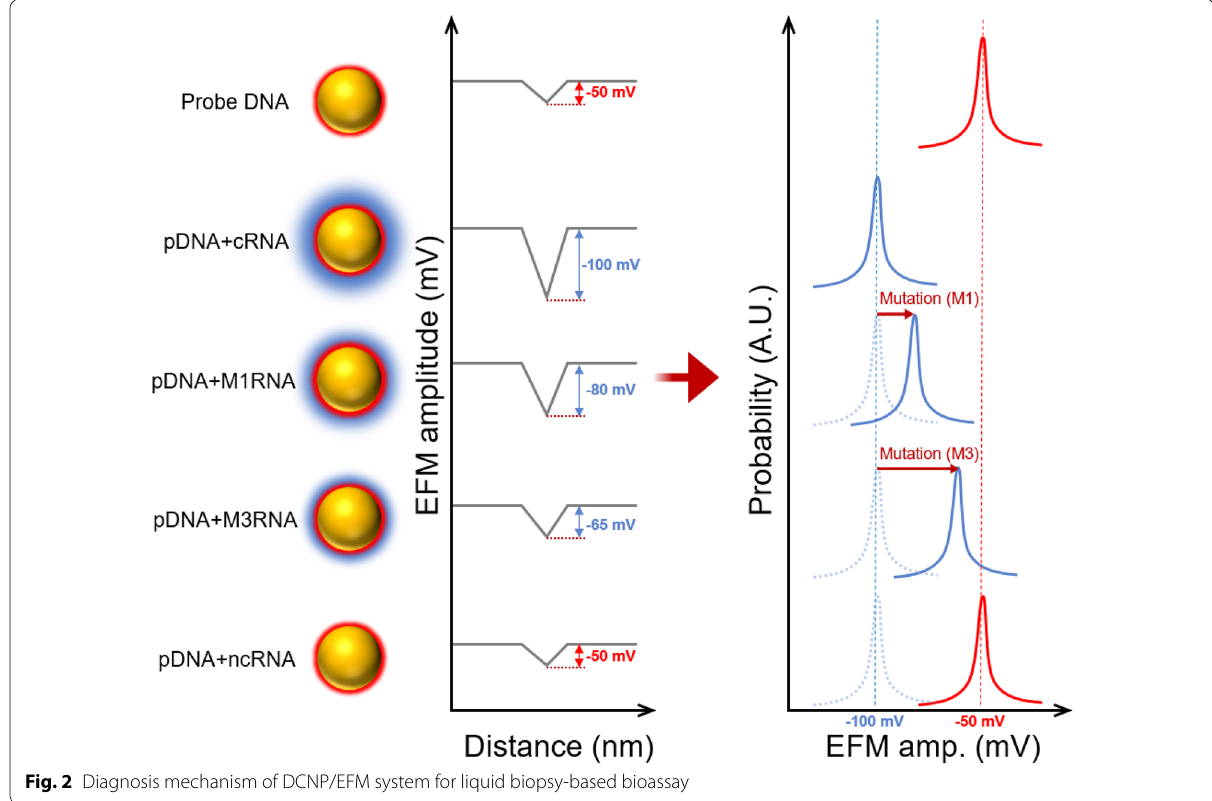
Fig. 2 Diagnosis mechanism of DCNP/EFM system for liquid biopsy-based bioassay